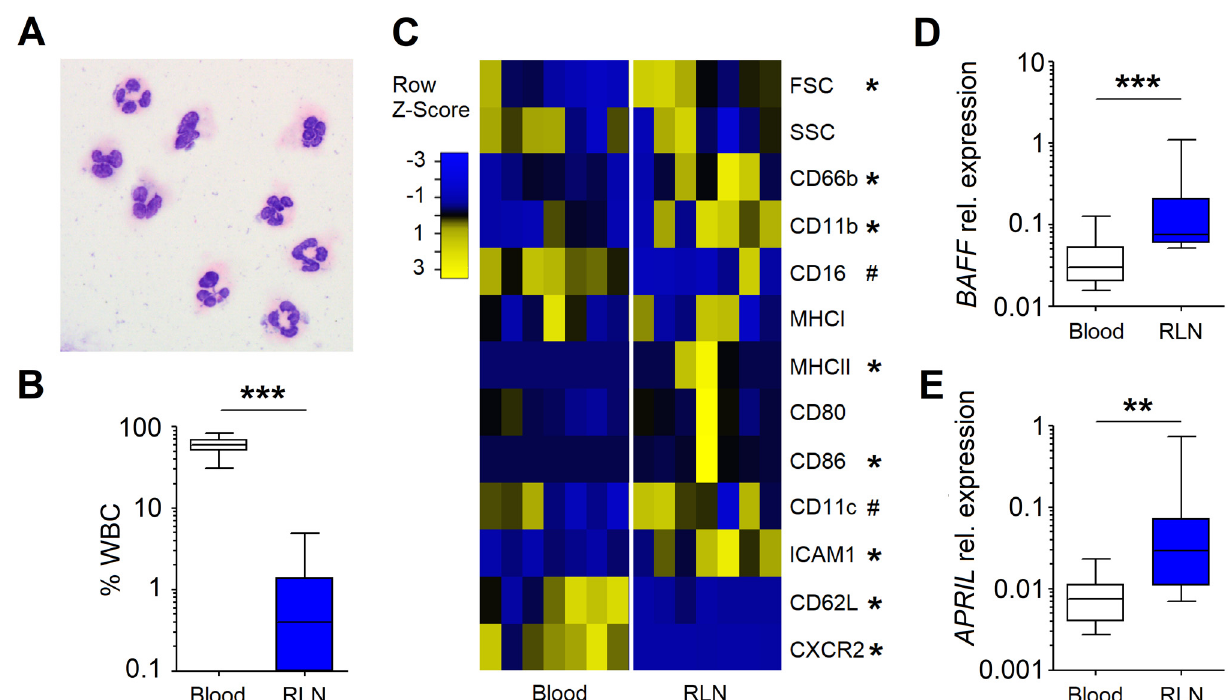
Figure 1. CD66b + neutrophils infiltrate the RLNs of HNC patients and exhibit N BH properties. ( A ) Giemsa staining of CD66b + cells isolated from the RLNs of HNC patients shows their segmented nuclei. Scale bar = 10 µ m. ( B ) The percentage of neutrophils from WBC, both in blood (white) and in RLNs (blue) from HNC patients ( n = 7). ( C ) Heatmap of the cell phenotypes of blood and RLN neutrophils isolated from HNC patients, assessed with flow cytometry ( n = 7). ( D ) Elevated BAFF gene expression in RLN neutrophils (blue) compared to blood neutrophils (white). ( E ) Elevated APRIL gene expression in RLN neutrophils (blue). A Mann–Whitney test for two independent samples and a Wilcoxon test for two dependent samples were used. Data are shown as median, 25–75 percentiles, min–max, *** p < 0.001, ** p < 0.01, * p < 0.05, # p = 0.06.